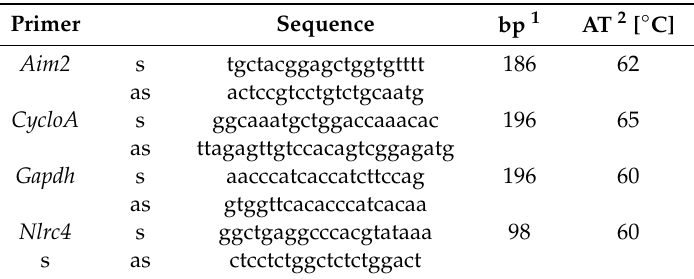
Table 2. List of used primers in the study.